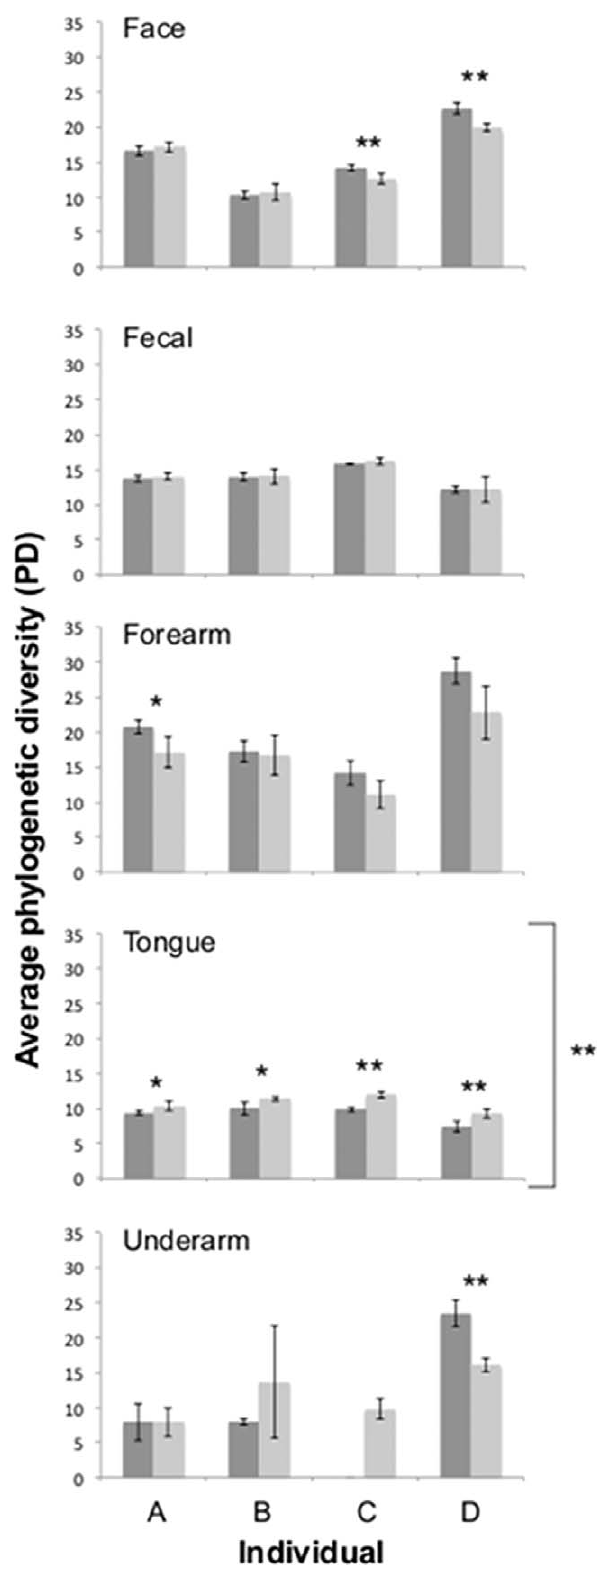
Figure 2. Average phylogenetic diversity observed for the communities of each body habitat of each individual using the direct PCR (dark grey) and standard extraction/purification (light grey) protocols. Bars with asterisks denote comparisons